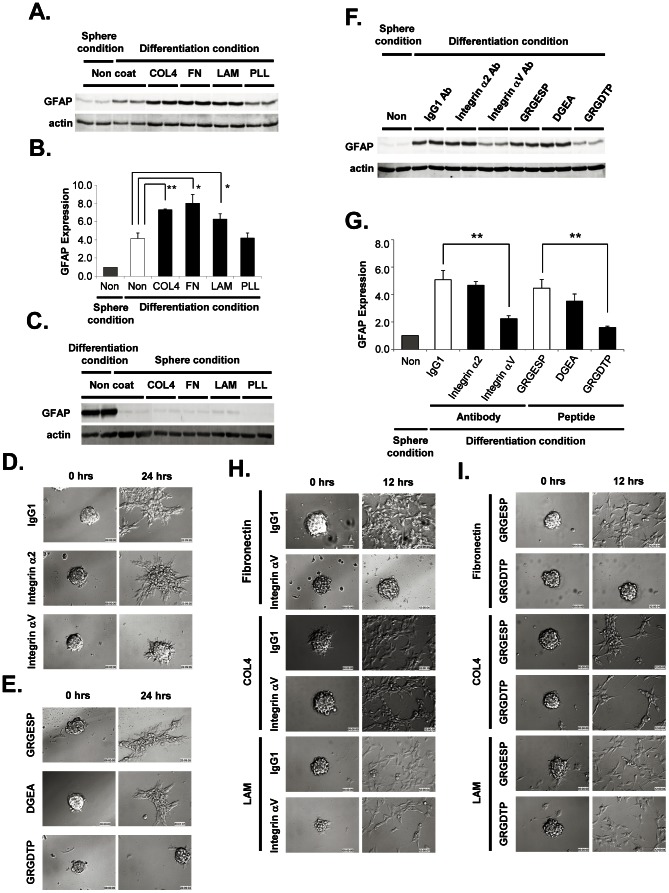
Adhesion, migration and differentiation of GICs on ECMs via integrin αV.
A. GFAP expressions in GICs cultured on ECM-coated dishes in the presence/absence of FCS for 48 hours was analyzed by western blotting. B. The intensity ratio of GFAP expression analyzed in (A) was quantitated using an actin internal marker. C. GFAP expressions in GICs cultured on ECM-coated dishes in the presence/absence of serum stimulation. The GIC spheres cultured on ECMs (COL4, LAM, FN) or PLL-coated dishes without serum, or on non-coated dishes with/without serum, were analyzed by western blot analysis at 48 hours after seeding. D and E. GIC spheres treated with blocking antibodies against integrin α2 and αV, or with control IgG (D), or with integrin-binding peptide DGEA, GRGDTP, or control peptide GRGESP (E) were stimulated by serum in non-coated dish. The representative stack photographs of the sphere at 0 hour and after 24 hours of FCS stimulation are shown. F. GFAP expression in GICs treated under the same conditions as in (D) and (E) for 48 hours was analyzed by western blotting. G. The intensity-ratio of the GFAP expression of GICs analyzed in (F) was quantitated. The values shown in (C) and (G) are means ±S.E of three independent experiments run in duplicate. *p<0.05 and **p<0.01. H. Effects of integrin blocking antibodies on GICs adhesion/migration on ECM-coated dishes. GIC spheres were treated with blocking antibodies against integrin αV or control IgG for 30 min before seeding onto ECM-coated dishes. Cell morphologies were analyzed by time-lapse microscopy. Representative stack photographs taken at 0 and 12 hours are shown. I. Effects of integrin-binding peptides on GICs adhesion/migration on ECM-coated dishes. GIC spheres were treated with integrin-binding GRGDTP, or control (GRGESP) peptides for 30 min before seeding into ECM-coated dishes. Cell morphologies were analyzed by time-lapse microscopy, and shown by the representative stack photographs at 0 and 12 hours.